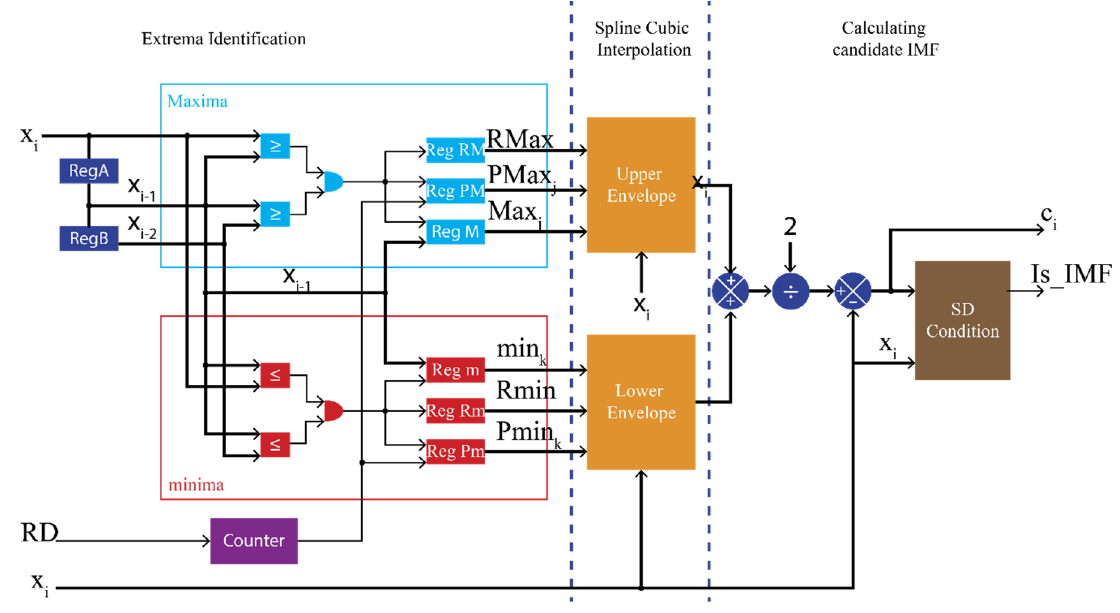
Figure 7. Sifting module.